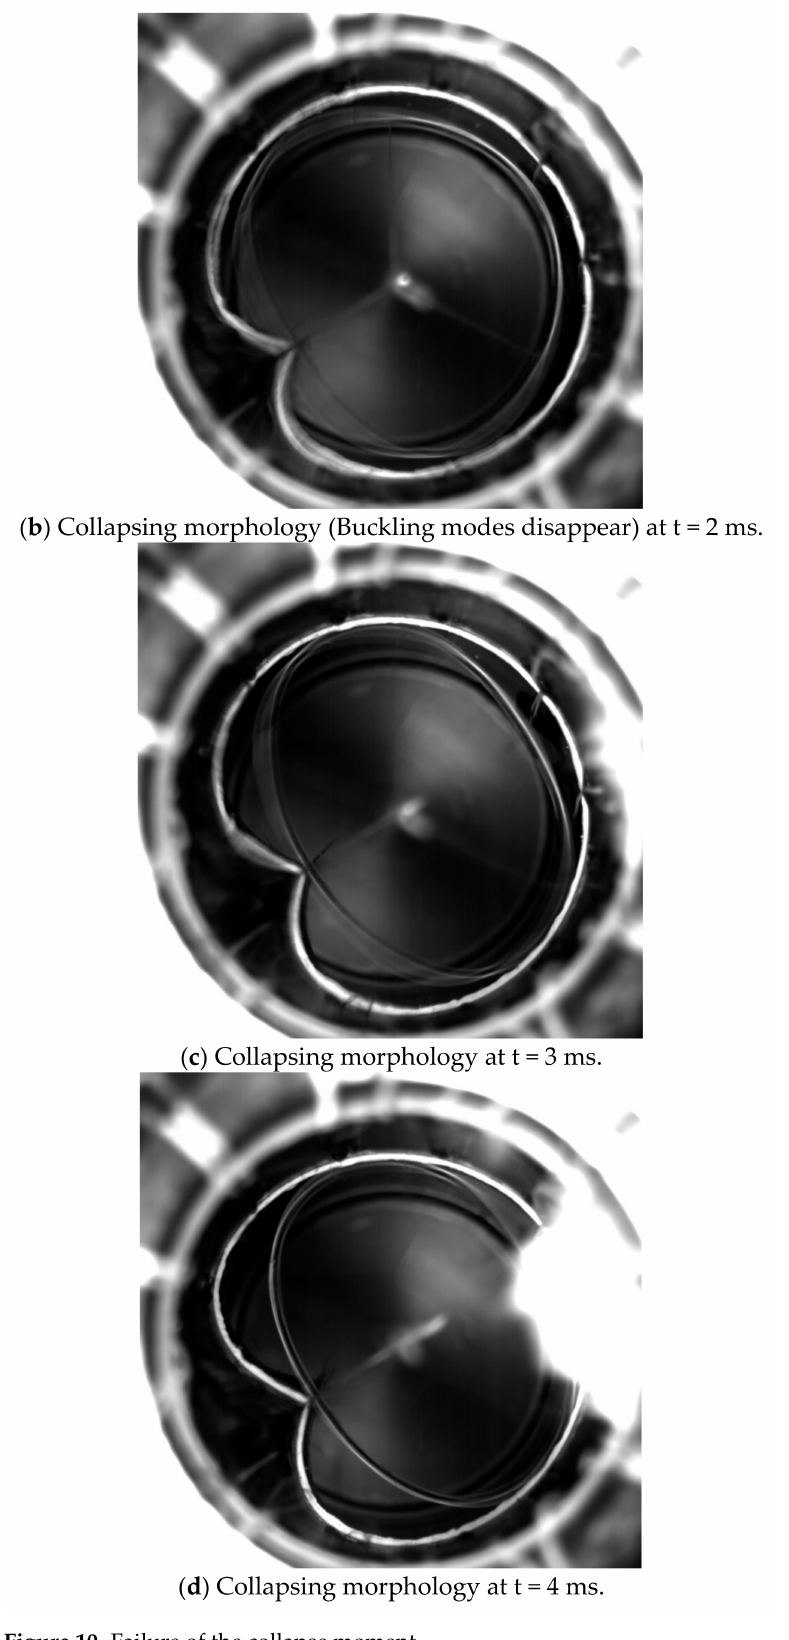
Figure 10. Failure of the collapse